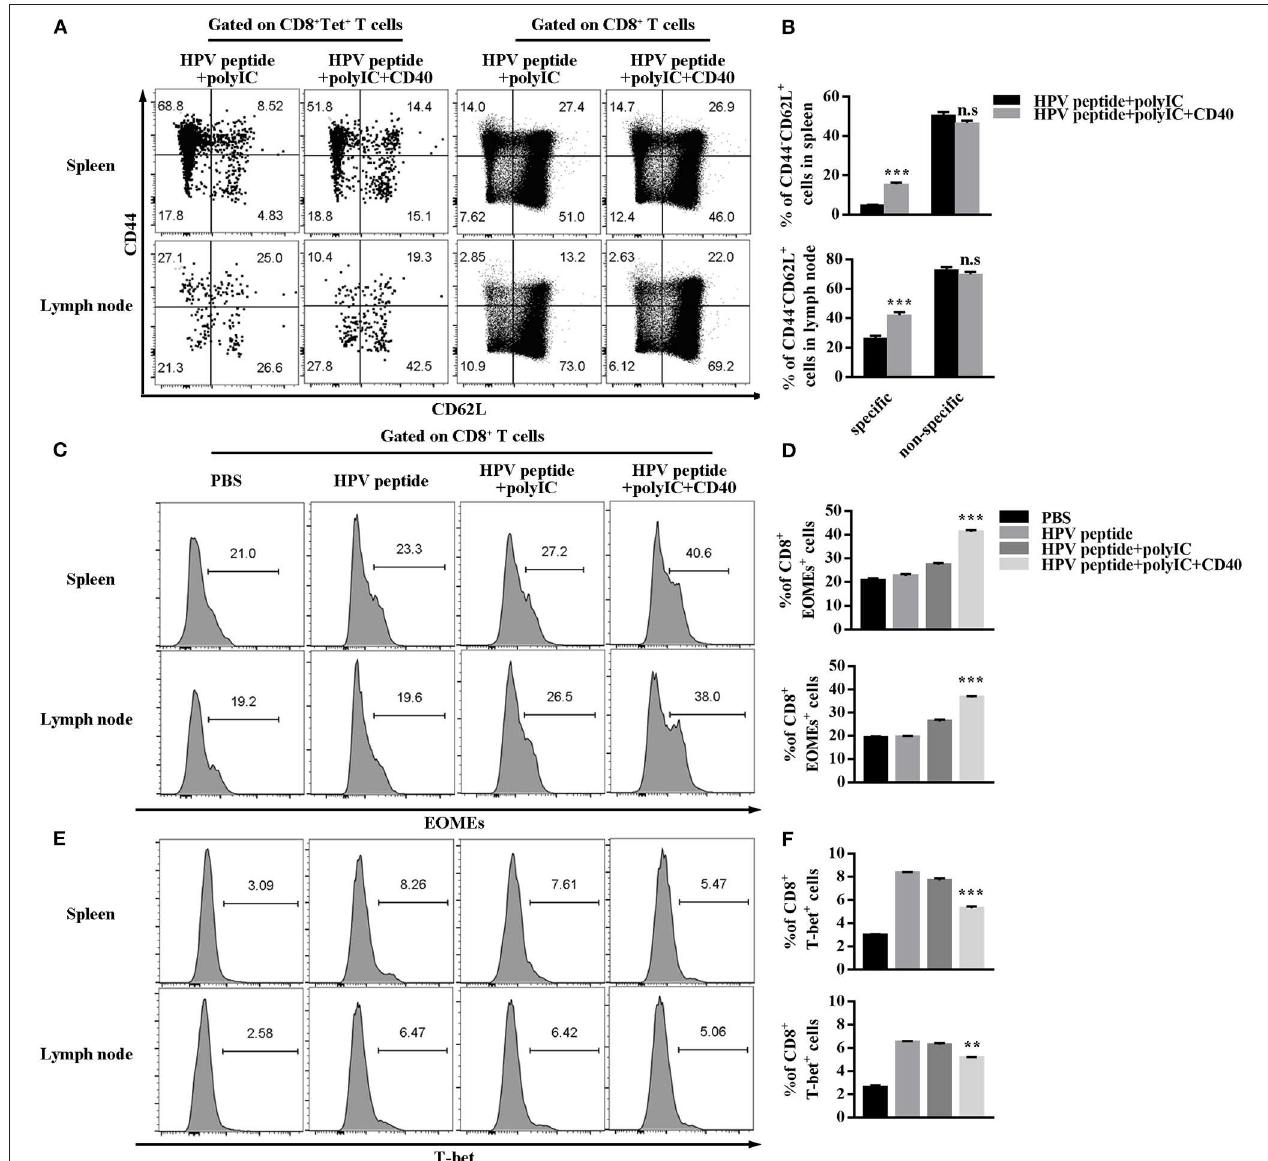
FIGURE 3 | HPV16 E7 peptide in combination with polyIC and aCD40 generates more Tscm and affects the expression of EOMEs and T-bet. (A,B) Distributions of HPV16 E7 specific and non-specific CD8 + memory T cells in spleen and lymph node were measured by FCS analysis 1 months after prime and boost induced by immunization using various vaccine formulations. Frequencies of EOMEs (C,D) and T-bet (E,F) gated on CD8 + T cells in spleen and lymph node were measured by FCS analysis 1 months after prime and boost induced by immunization using various vaccine formulations. Error bars represent the mean ± SD of three independent experiments. ** p < 0.01, *** p < 0.001, n.s, p >